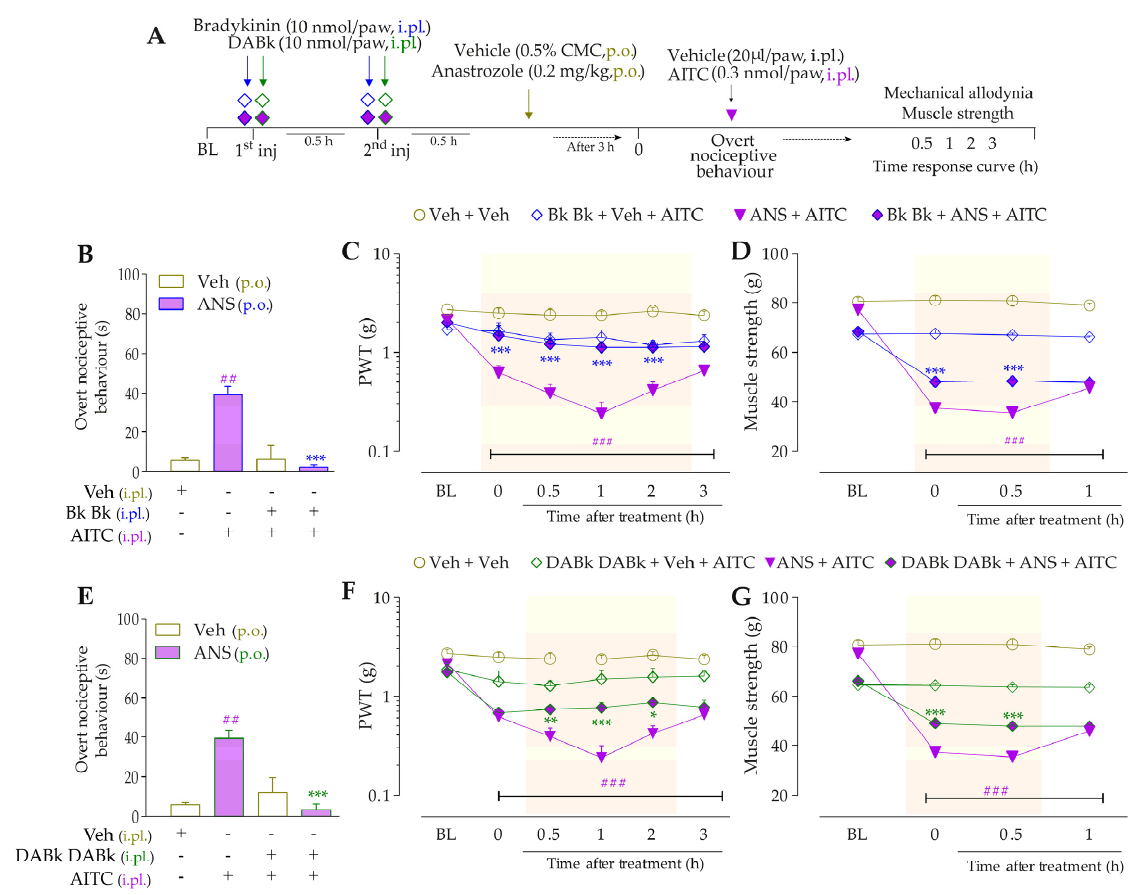
The desensitization protocol by intraplantar injection of Bk (Figure 6B) or DABk (Figure 6E) completely abrogated the AITC-induced overt nociceptive behaviors in anastrozole-treated mice (inhibitions of 93 ± 3% and 91 ± 7%, respectively) compared to anastrozole plus AITC-treated non-desensitized mice. In these same animals, the local desensitization with Bk and DABk also abolished the mechanical allodynia from 0.5 h up to 3 h (inhibition of 47 ± 10% at 0.5 h and 27 ± 5% at 1 h, respectively) (Figure 6C,F) and muscle strength loss from 0.5 h up to 1 h (inhibition of 33 ± 2% and 32 ± 2% at 0.5 h, respectively) (Figure 6D,G) after its injections, when compared to the non-desensitized group anastrozole plus AITC.